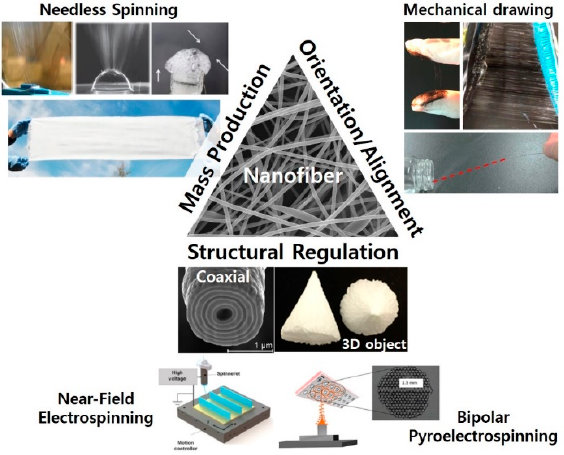
Figure 1. Challenges in the conventional nanofiber fabrication technique and different notable approaches for advanced nanofiber production. [Reproduced with permission from 42, 63, 98, 81, 87, and 91. Copyright (2017, 2016, 2019, 2019, 2019 and 2019) American Chemical Society].